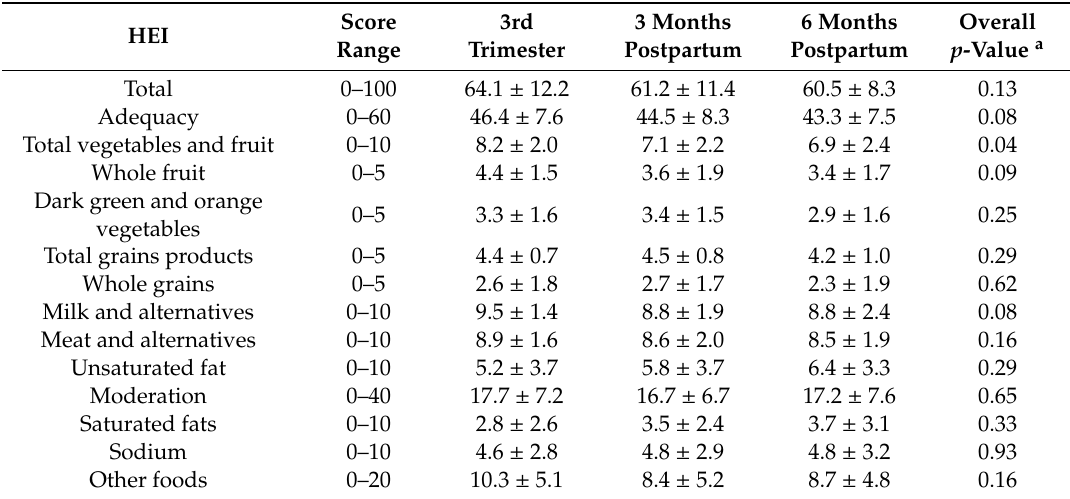
Table 6. Healthy Eating Index total and subscores from late pregnancy to